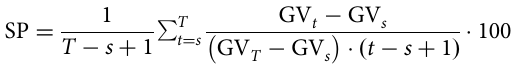
Figure 1 is a world map of the Stringency Speed. As China and Taiwan have a much higher value than the rest of the world, we distinguish them with a black color. Overall, the highest values of stringency speed can be found in East and Southeast Asia. Italy and Germany are the highest in Europe.